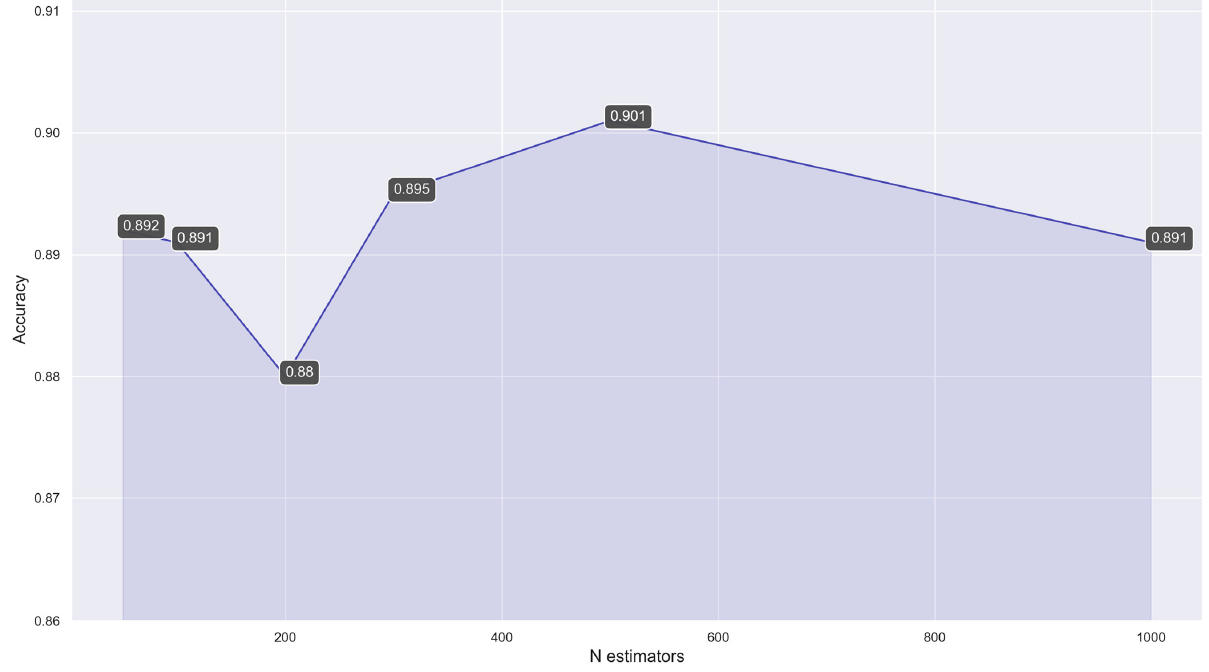
Figure 4. The dependence of forecasting accuracy on the number of decision trees.